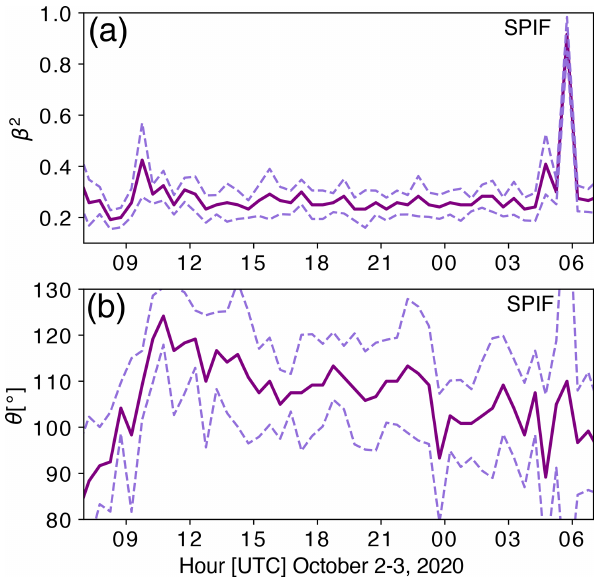
Figure B7. Back-azimuth analysis at the SPIF station. (a) Non-smoothed polarization degree β 2 . The impulsive high-value polarization levels at ∼ 06:00UTC on 3 October can be associated with anthropogenic noise sources, and they are also visible on different days. (b) Non- smoothed back-azimuth direction θ , averaged over 3–8Hz. The mean is shown by a solid line and the standard deviation by the dashed lines.